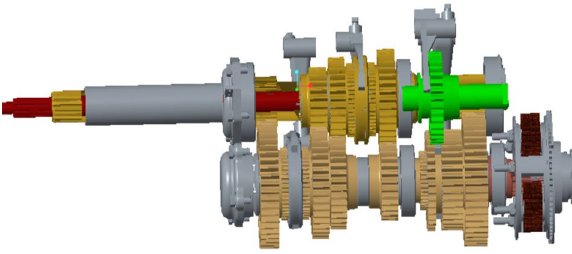
Figure 6. Three-dimensional diagram of transmission gear shaft.